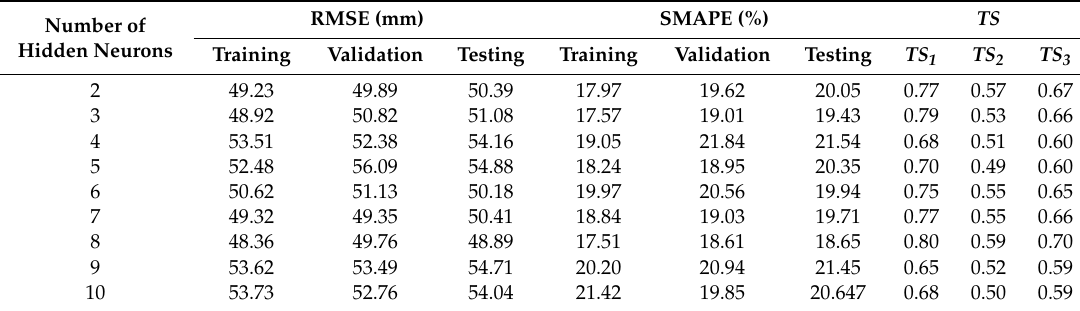
Table 6. The performance for training, validation, and testing parts of the LSTM model with all 13 input variables. Number of Hidden